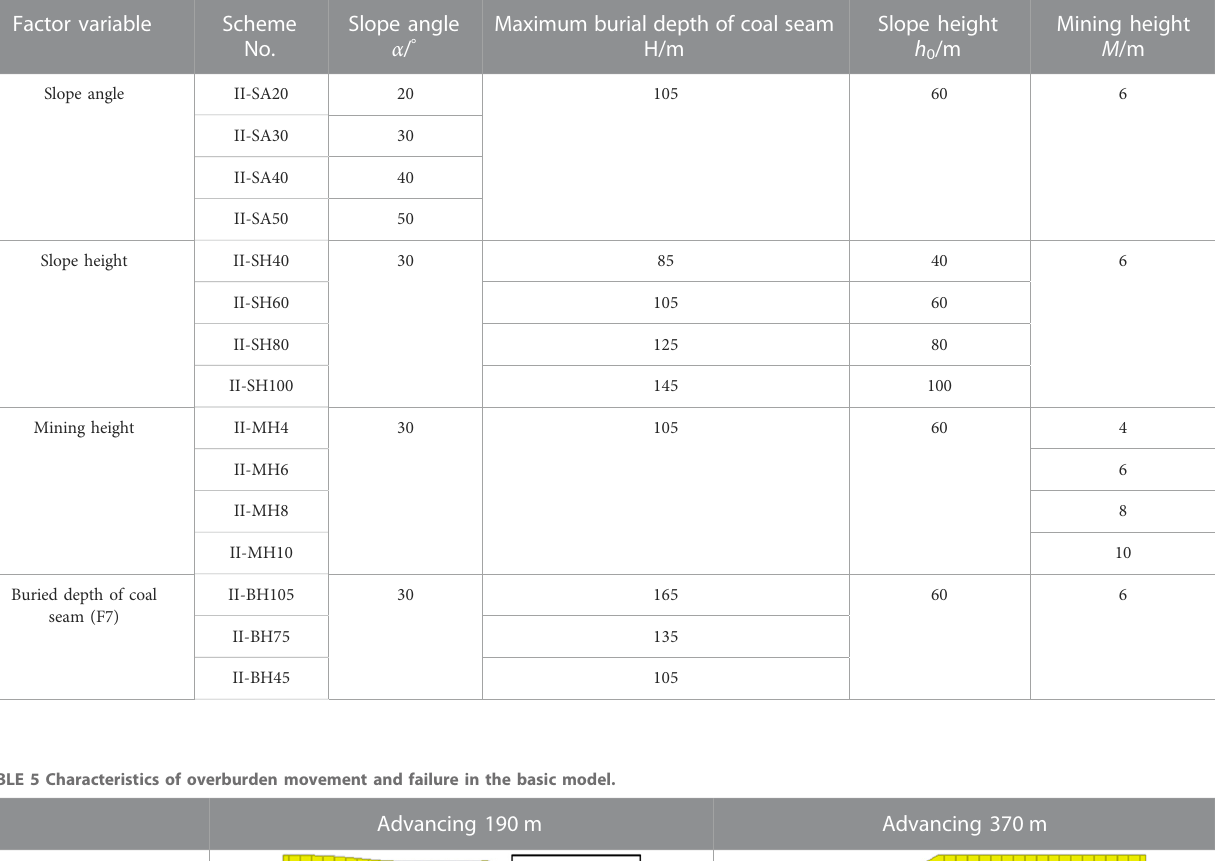
TABLE 4 Experimental model scheme for Class II slope.